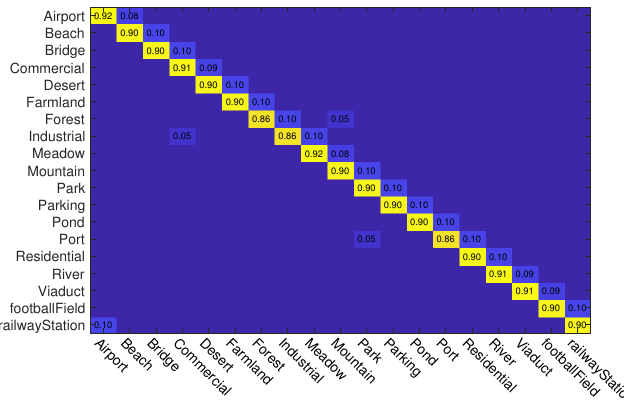
Figure 11. Confusion matrices obtained by ADRL-Net with ResNet50 as backbone on the WHU-RS19 dataset. Tr = 60%.